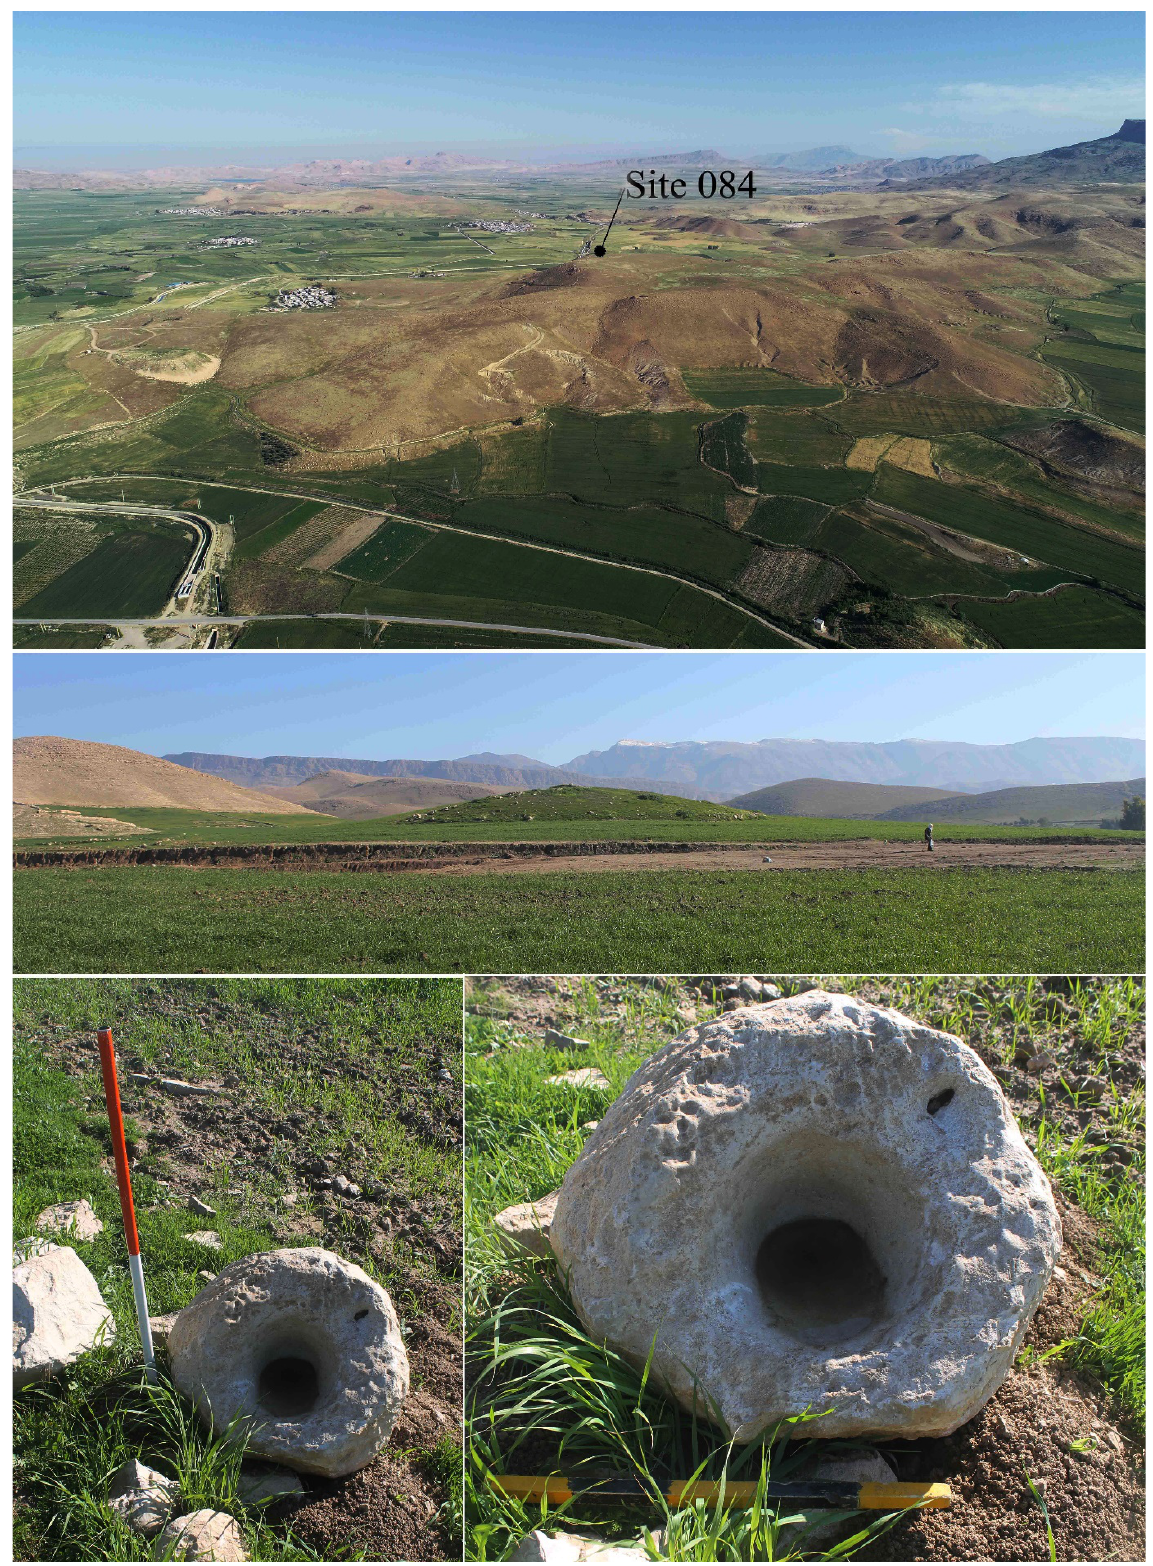
Figure 6. Aerial view of Tapeh Taher and its rock mortar (courtesy of Reza